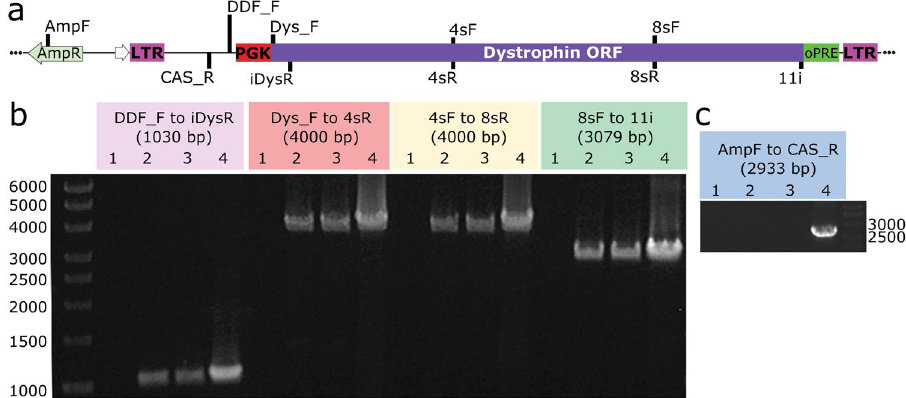
Figure 4. Full-length FVV is integrated in transduced muscle derived cells. ( a ) A map of the transfer plasmid pDDF-PGK-Dys-oPRE is shown (not to scale) with the positions of primers used for PCR in panels B and C indicated. PCR products were visualised following separation by DNA gel electrophoresis using the primers indicated above each lane ( b , c ). The expected amplicon size is given in brackets for each primer set. All lanes are numbered according to the PCR template. Template for lanes 1–3 were genomic DNA from muscle derived cells (cell line 2) where 1 was untransduced; 2 was transduced with FVV-PGK-Dys and 3 was transduced with FVV-PGK-Dys-oPRE. Lane 4 template was plasmid DNA (pDDF-PGK-Dys-oPRE). Numbers next to the DNA ladders show the size of the adjacent band in bp. Full length gel images are shown in Fig.